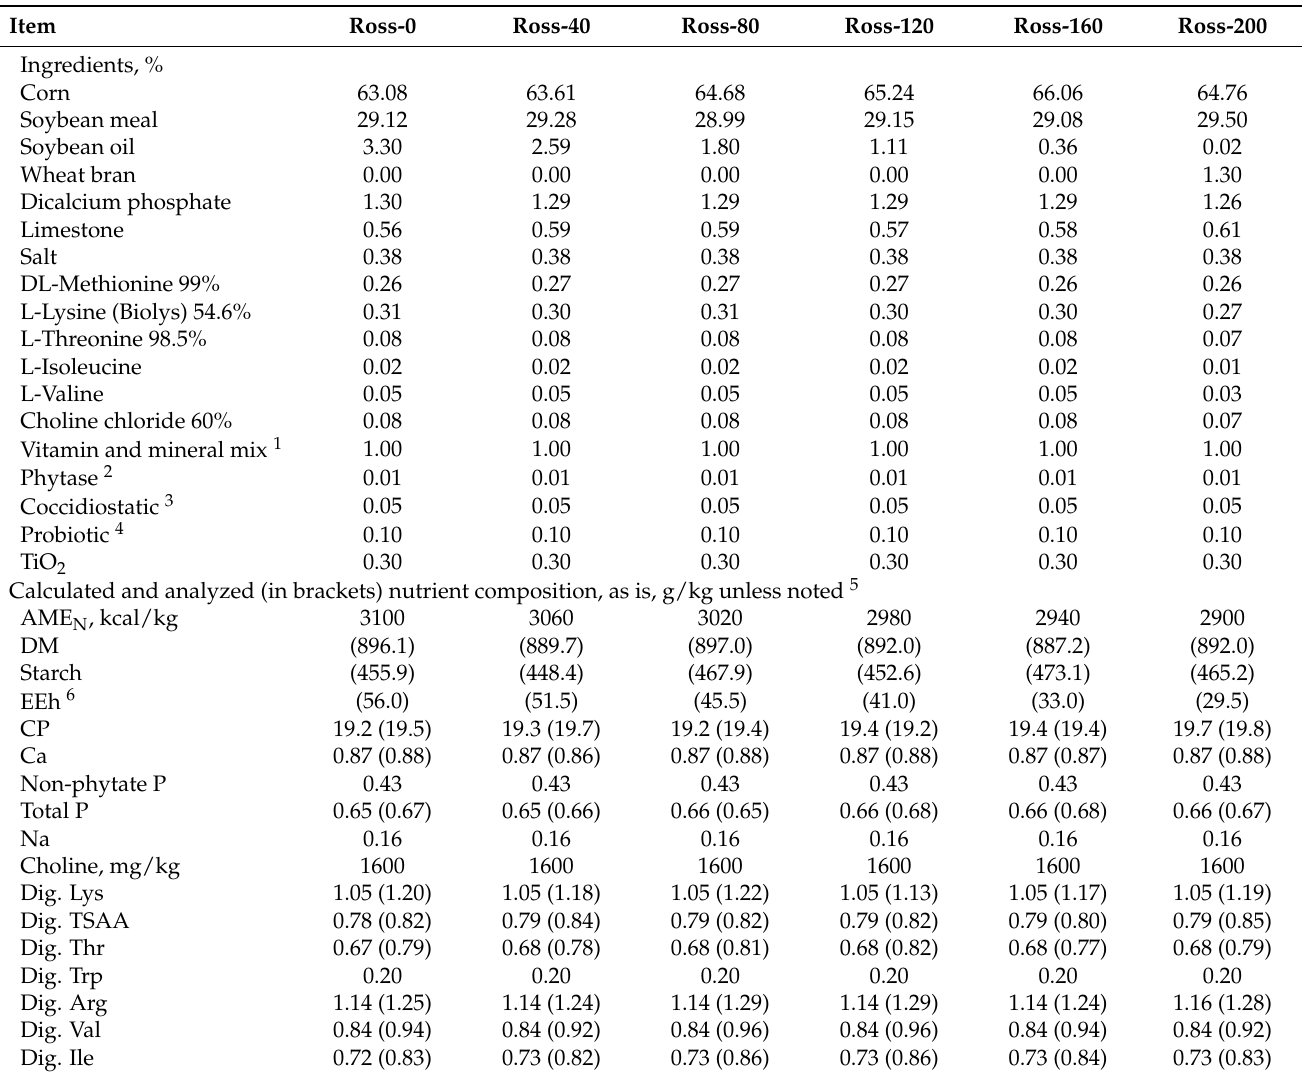
Table 2. Ingredient and nutrient composition of the experimental diets used as grower, as